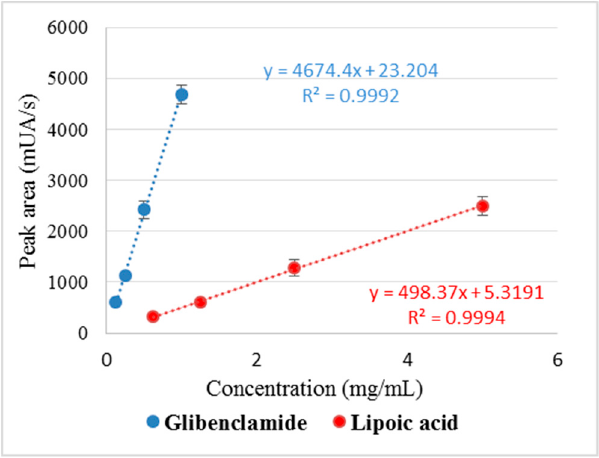
Figure 3. Standard curve and correlation coefficient (R 2 ) values for glibenclamide and lipoic acid.